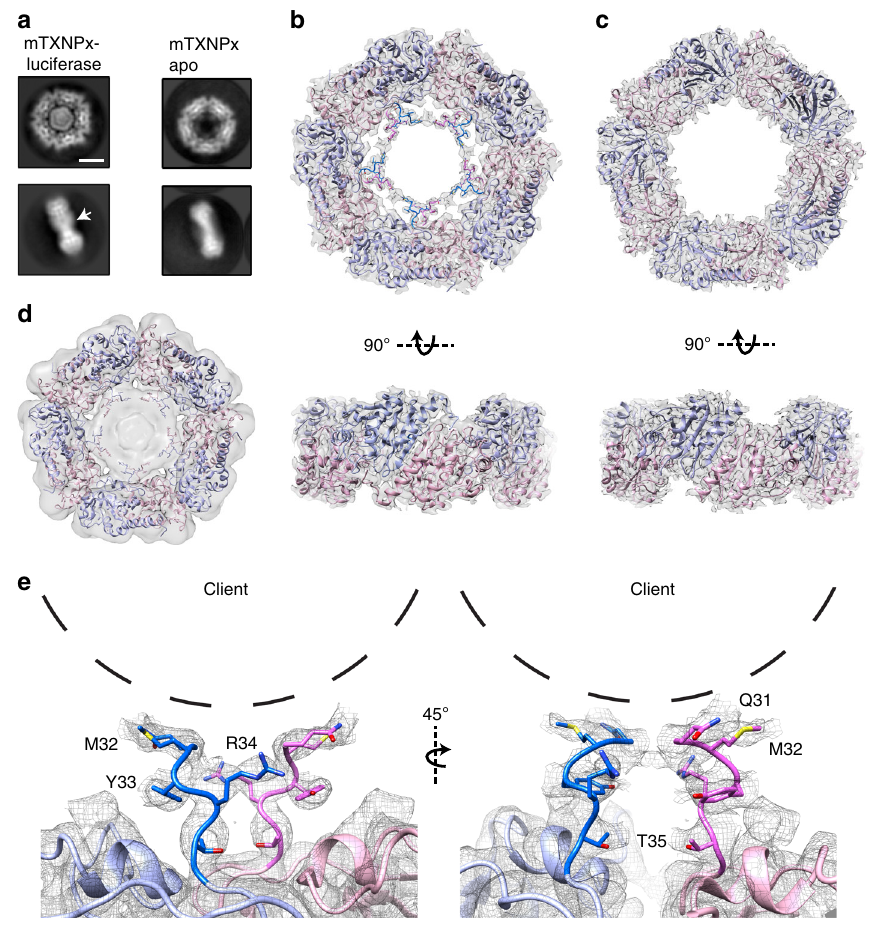
Fig. 1 Cryo-EM structure of the mTXNPx red : luciferase complex. a 2D reference-free class averages of heat-treated mTXNPx red in the presence (left) or absence (right) of unfolded luciferase showing additional central density attributed to luciferase in top and side (arrow) views. Scale bar equals 5 nm. Cryo- EM 3D map of the mTXNPx red :luciferase complex ( b ) and mTXNPx alone ( c ) resolved to 3.7 and 2.9 Å resolution, respectively shown at σ = 3.3. Top and side views are shown. The L. braziliensis mTXNPx crystal structure (4KB3) was docked into the EM density with additional N-terminal residues, Q31-T35, modeled for mTXNPx red :luciferase. d The unsharpened map of the mTXNPx red :luciferase complex displayed at threshold σ = 1.7 showing central density corresponding to bound client. e N-terminal residues Q31-T35 shown docked into the sharpened mTXNPx red :luciferase map with approximate location of client (dashed line) adjacent Q31, M32, Y33, and R34 (Supplementary Figure 1G). A homology model from Leishmania Table 1 Summary of atomic modeling statistics and braziliensis (pdb: 4KB3), a close homolog of L. infantum 12 , was validation